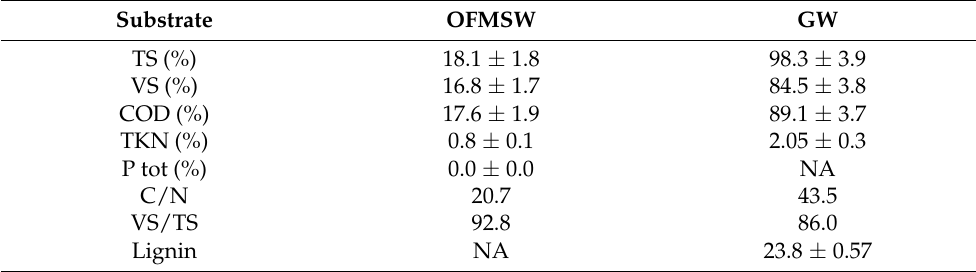
Table 1. Chemical compositions and characteristics of fresh biomasses (OFMSW and untreated GW) (OFMSW = organic fraction of municipal solid waste; GW = green waste).